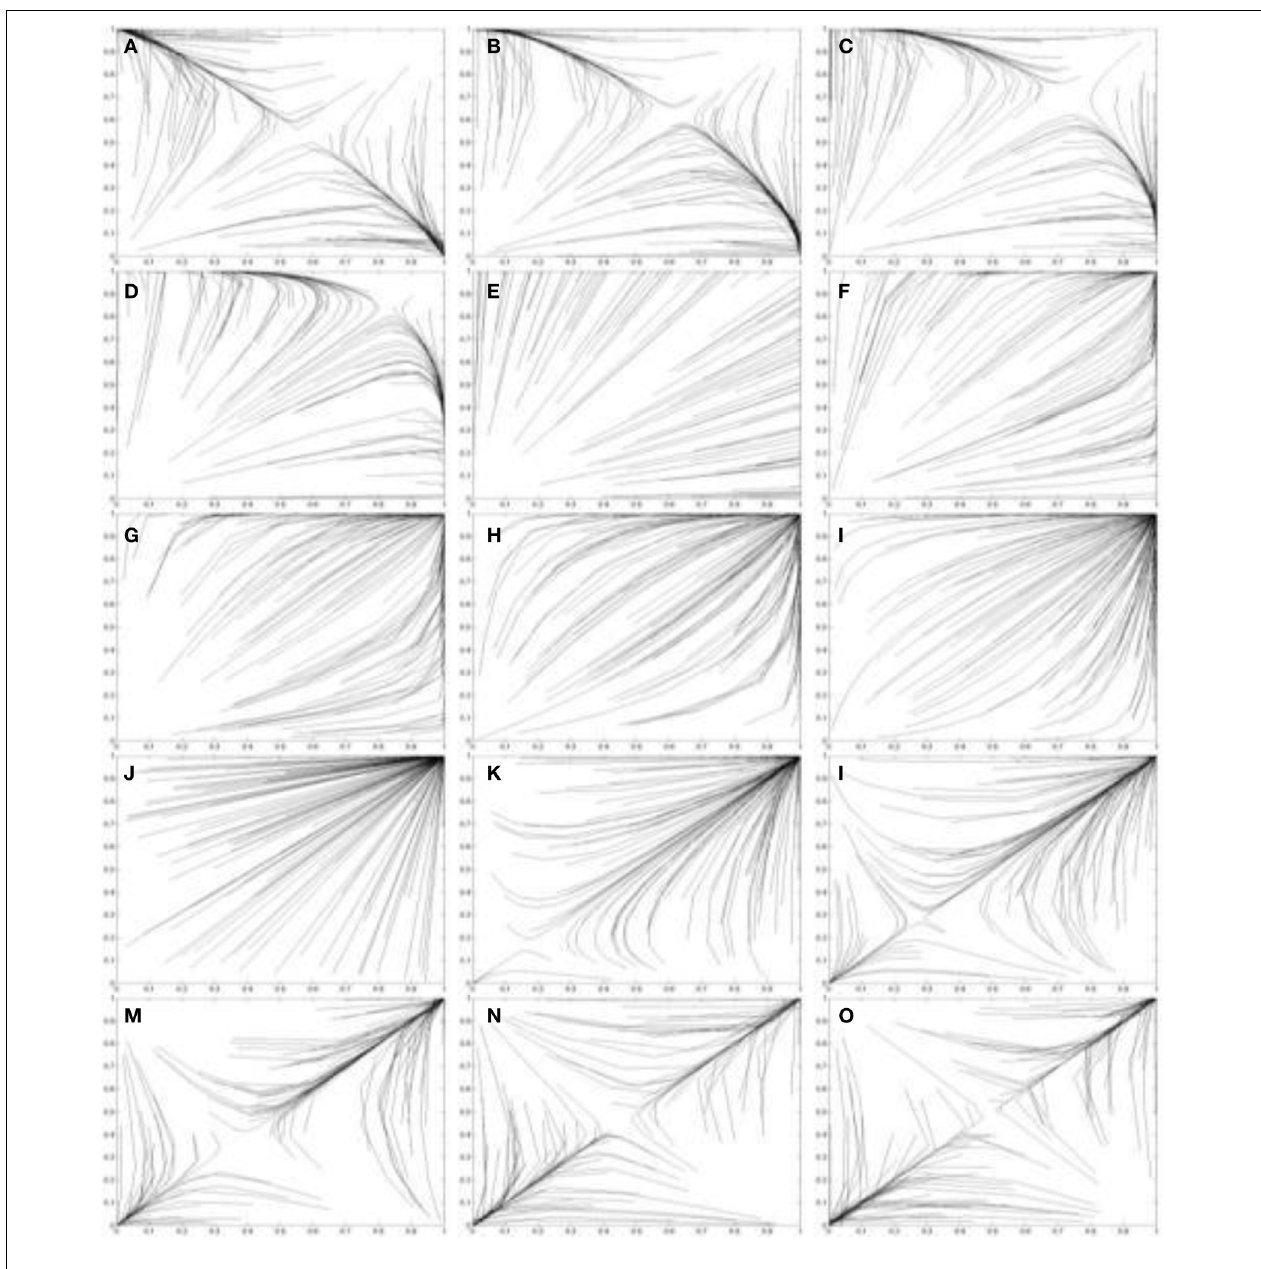
FIGURE 7 | Simulations of one hundred pairs of agents playing thirty iterations of the Leader game. Agents share different values of I ∗ j in each simulation. (A) I ∗ j = 3 . 8; (B) I ∗ j = 3 . 6; (c) I ∗ j = 3 . 4; (D) I ∗ j = 3 . 2; (E) I ∗ j = 3 .